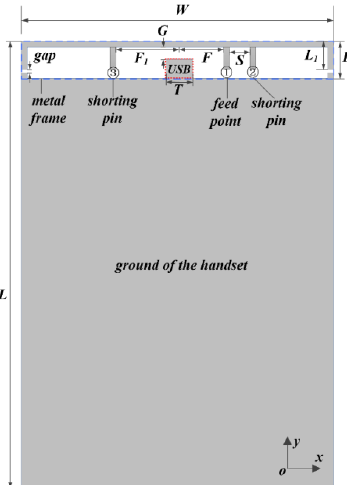
Figure 1. Proposed T-shaped antenna configuration with a feed point, two shorting pins and a USB